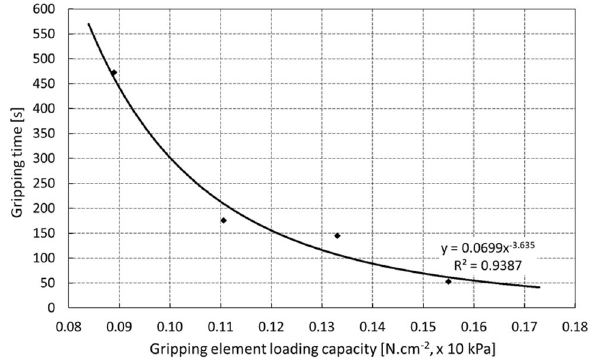
Fig. 11 Gripping time of the object at the optimal initial element